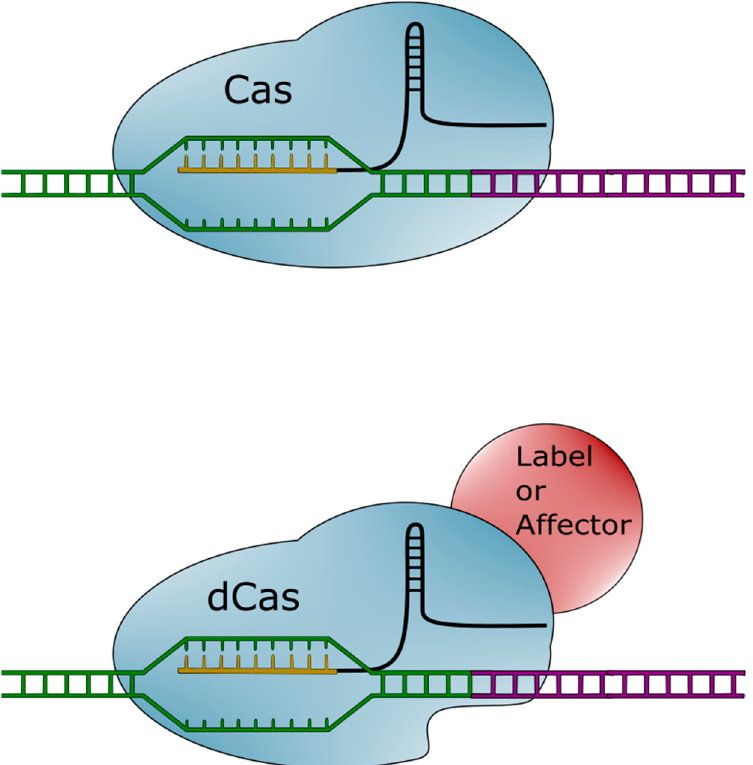
Figure 2. Diagram of clustered regularly interspaced short palindromic repeats-associated (Cas) system variants. The Cas (upper) system targets a specific genomic region (green) with its single guide RNA (sgRNA) (gold and black). The Cas protein will then make a cut in the adjacent DNA region (purple). The catalytically inactive Cas (dCas) (lower) system targets a genomic region with an identical system. However, the dCas protein lacks endonuclease activity. Various molecules (red) can be fused to the dCas protein. These include labels and affectors. Labels bring a fluorescent signal in close proximity to target DNA, while affectors can modify characteristics, such as the epigenetic state of DNA.